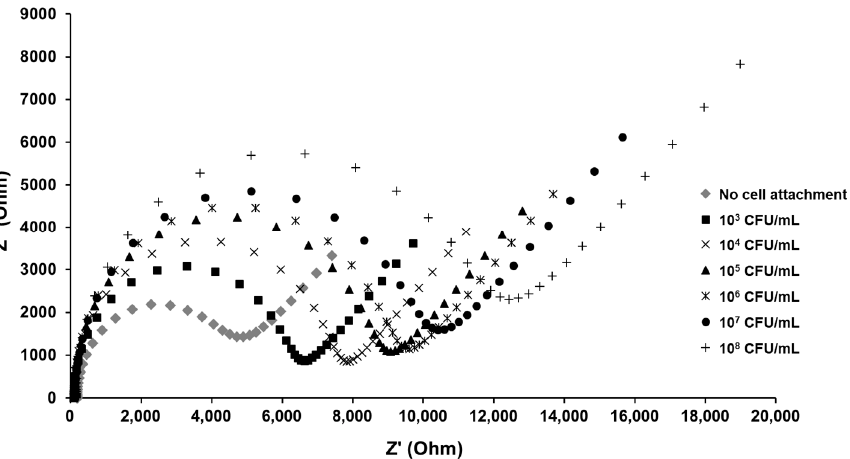
Figure 5. Electrochemical impedance spectra of the E. coli MEI sensor without E. coli K12 cell attachment and with E. coli K12 cells binding to the surfaces.